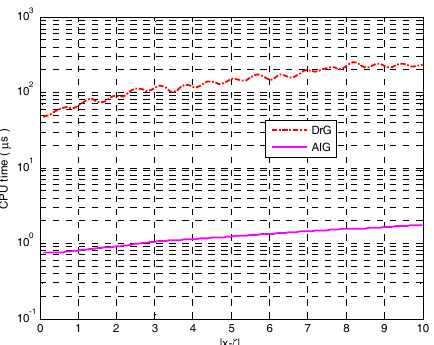
Figure 10. Computation time ( μ s) for each implementation of the Green’s kernel, by the two methods, respectively, as a function of point distance | x − ξ |. The figure is obtained based on averaged CPU time of 1 million evaluations of the two codes, respectively, for every input of the wave period ω .